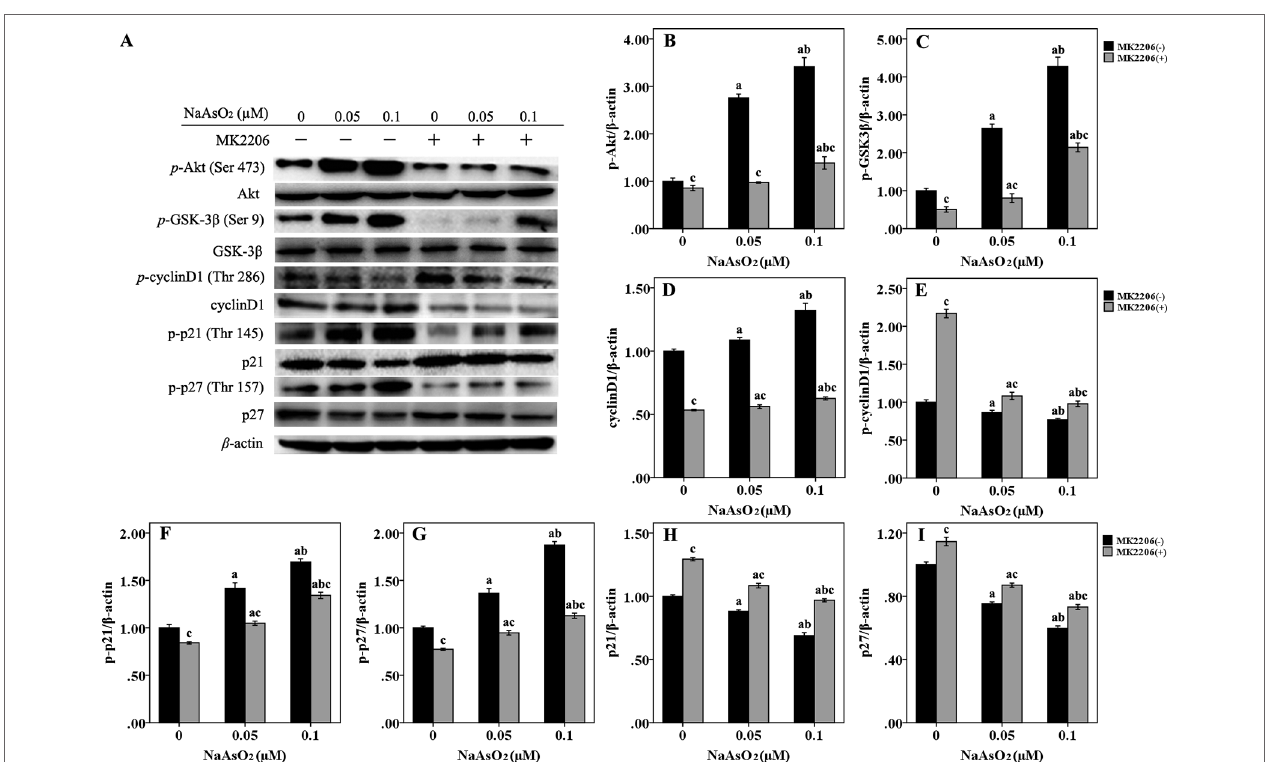
FIGURE 4 | Repeated low-dose NaAsO 2 exposure induced phosphorylated protein expression of GSK-3 β /cyclinD1, p21 and p27 was regulated by AKT. Protein expression was detected by the Western blot analysis. (A) Images are the representative results of three separate experiments. Quantitative graphs ( n = 3) showed the relative intensity of the target proteins compare with β -actin, including p -AKT (B) , p -GSK-3 β (C) , total cyclin D1 (D) , p -cyclin D1 (E) , p -p21 (F) , p -p27 (G) , total p21 (H) and total p27 (I) . NaAsO 2 exposure induced increased expression of p -AKT, p -GSK-3 β , total cyclin D1, p -p21, and p -p27, but decreased expression of p -cyclin D1, total p21, and total p27. Treatment of MK2206 significantly reversed the expression of all of the above proteins. Significant difference was defined as p less than 0.05. a, vs. the corresponding 0 μM group; b, vs. the corresponding 0.05 μM group; c, vs. the MK2206(-) group of the same NaAsO 2